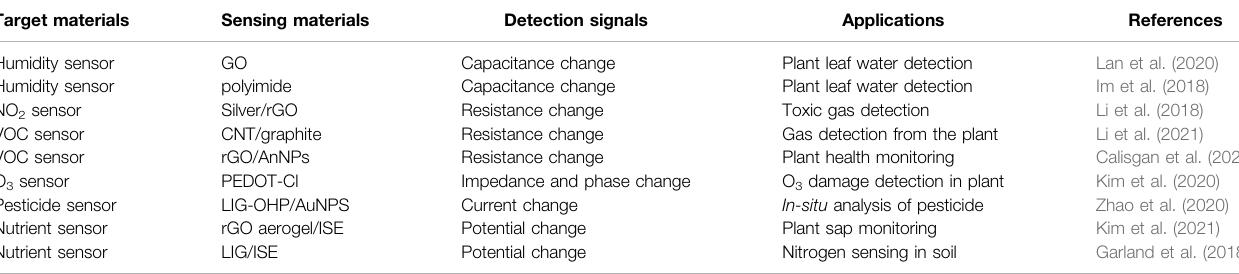
TABLE 2 | Electrochemical system-based plant signal sensors.